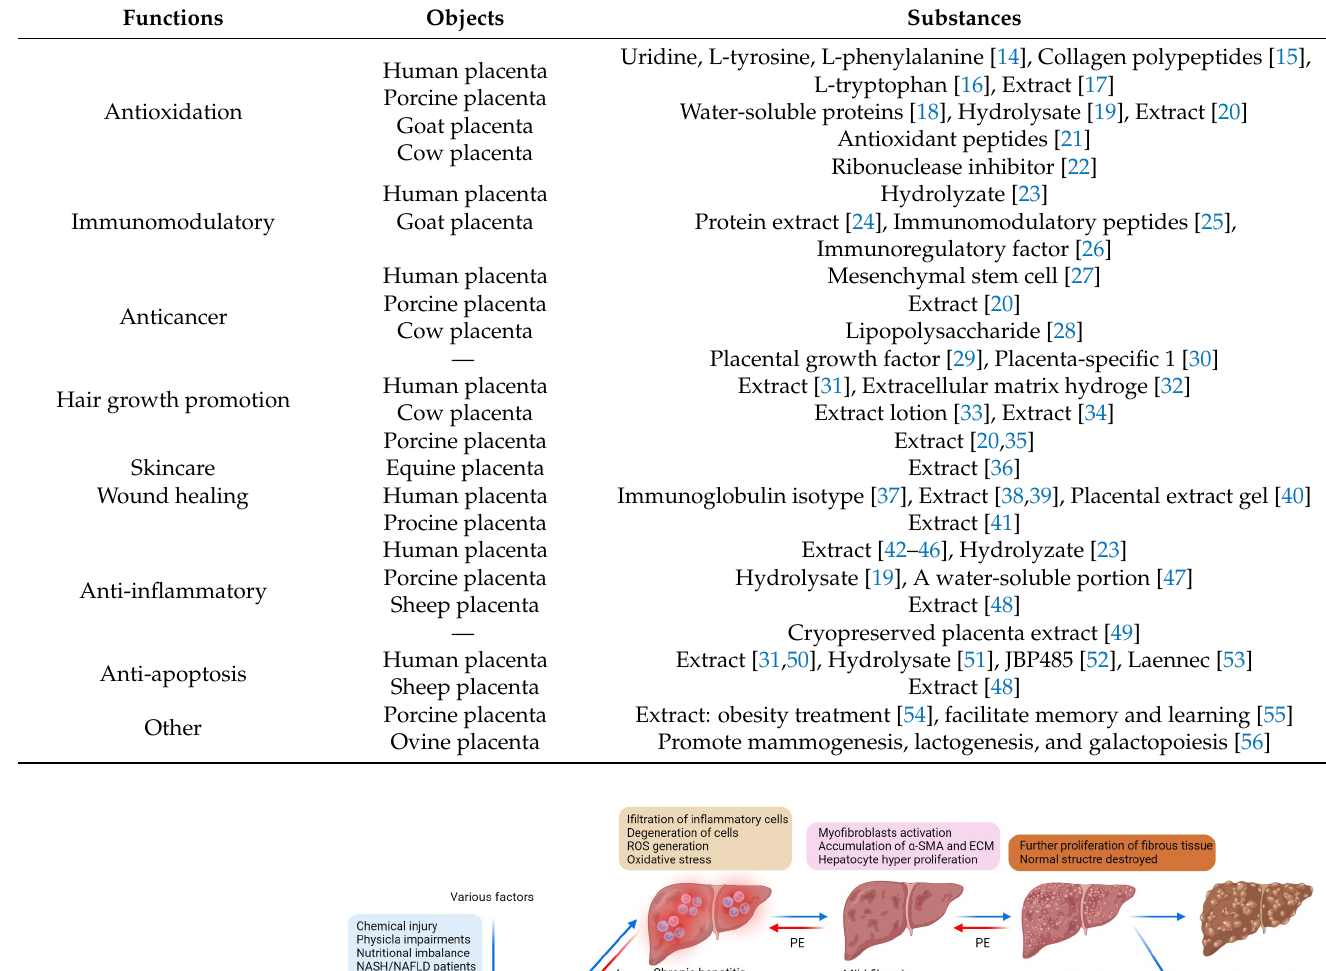
Table 1. Main functions of PE.